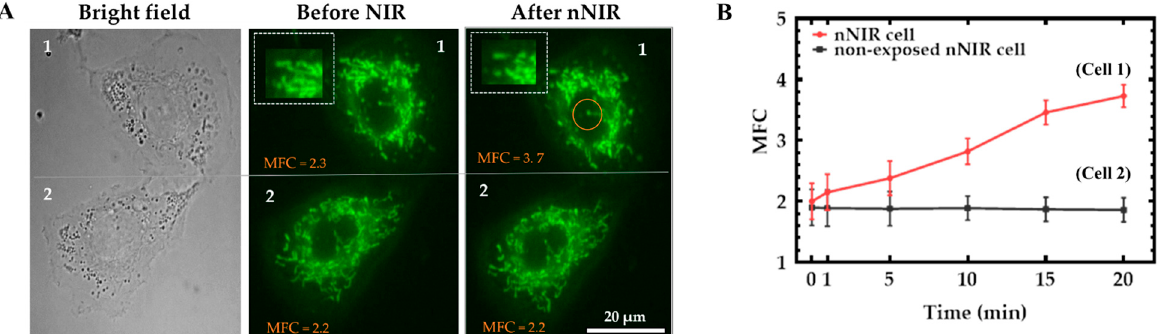
Figure 2. Exposure of A549 cell before and after to nuclear 224.02 J/cm 2 NIR for 10 s. ( A ) Cell 1 on the left panel illustrates the bright field of the cell. Cell 1 located in the middle panel is the fluorescence image before nNIR, and cell 1 on the top right panel illustrates cell 1 after 20 min of nNIR (laser spot area in brown circle cell 1), where the fluorescence imaged cell showed a fragmented mitochondrial structure in cell 1 located at the top right panel after 20 min of nNIR. ( B ) MFC of single cell nuclear NIR showed a significant ( p < 0.01) increase of nuclear exposed cell (Cell 1: MFC = 3.7 ± 0.2) but no MFC change in non ‐ exposed nNIR cell (Cell 2: MFC = 1.9 ± 0.2) .